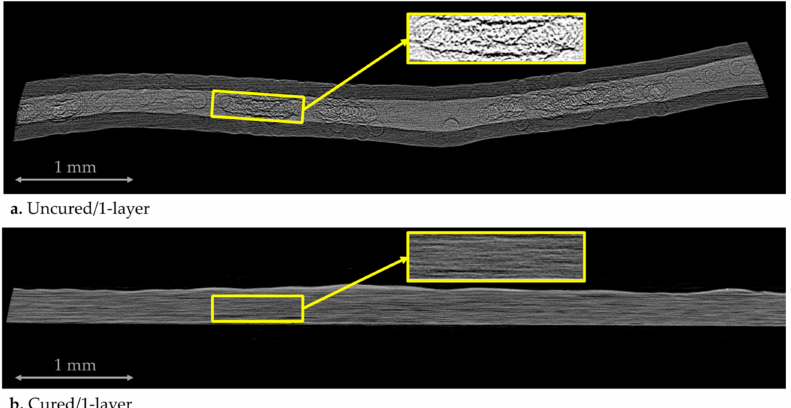
Figure 7. X-ray micrographs: ( a ) uncured/1-layer and ( b ) cured/1-layer. Additional inserts highlight the visible dry fiber tow areas for uncured samples and relatively dry regions for cured samples.